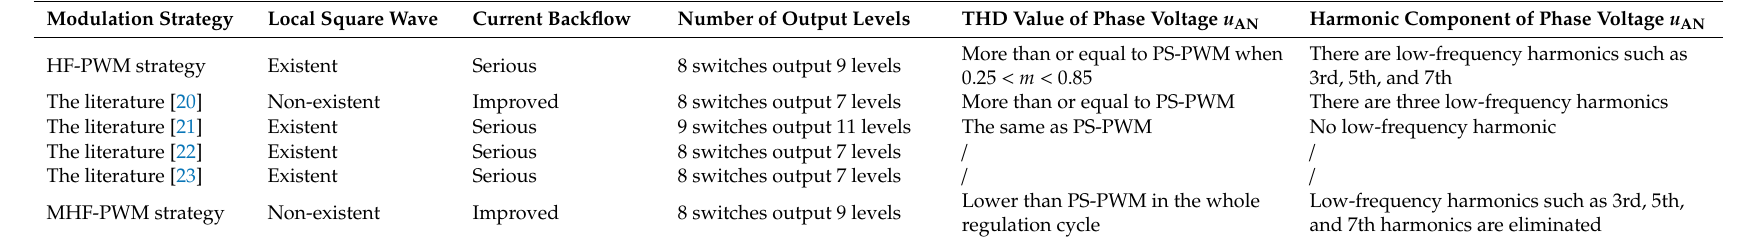
Table 5. Comparison of di ff erent